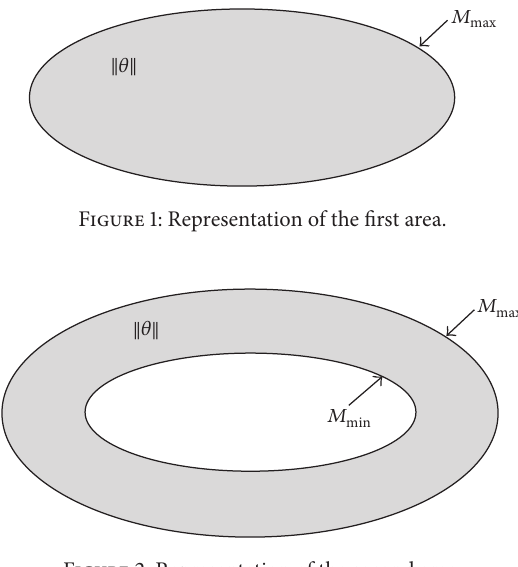
Figure 2: Representation of the second